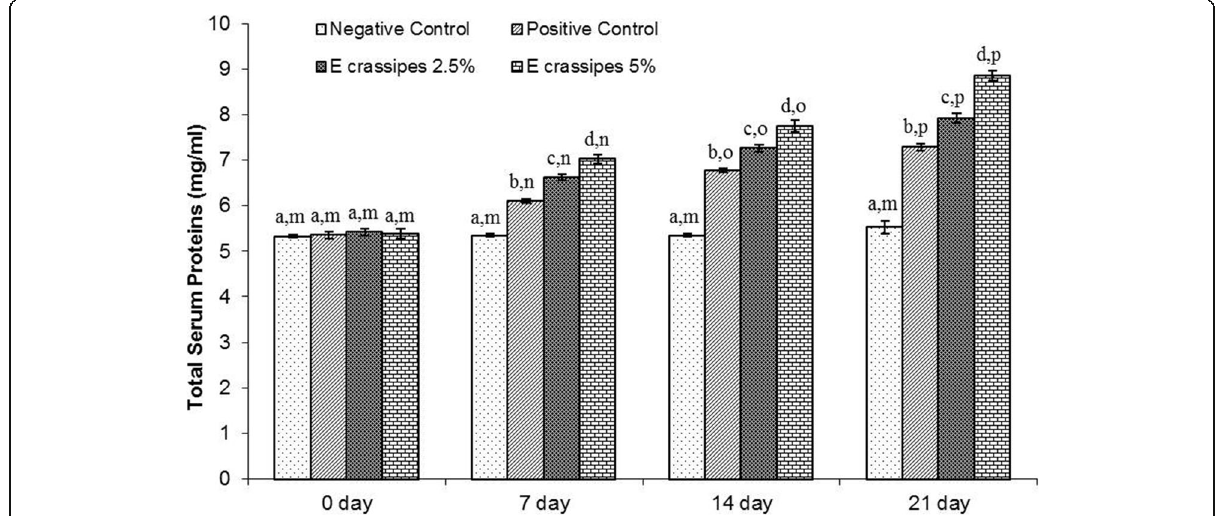
Fig. 4 Total serum proteins in serum samples of various groups of C. punctata on days 0, 7, 14, and 21. Values are expressed in mean ± SEM. p values were calculated using one-way ANOVA followed by Student Newman-Keuls ’ multiple range test, and p values ≤ 0.05 are statistically different. Error bars with dissimilar superscripts differ significantly. Values compared within four groups, specific time point is represented by superscripts “ a ” to “ d, ” and within groups at various time points is represented by superscripts “ m ” to “ p ”